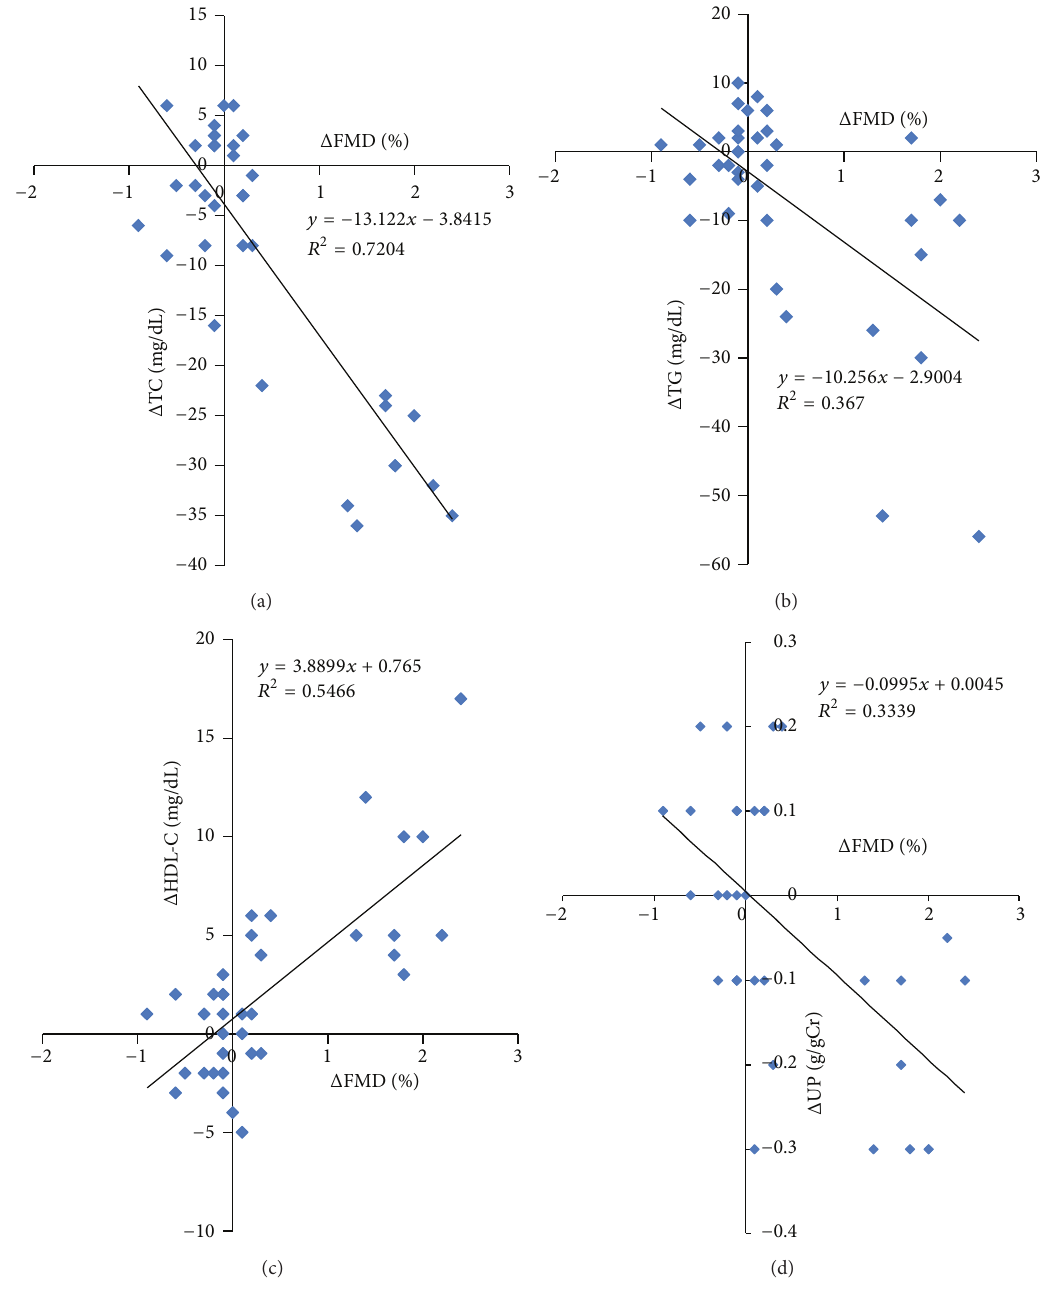
Figure 2: Relationship between changes in flow-mediated vasodilation (FMD) and that of TC ( 𝑃 < 0.0001 ), TG ( 𝑃 < 0.0001 ), HDL-C ( 𝑃 < 0.0001 ), and UP ( 𝑃 < 0.05 ). TC: total cholesterol; TG: triglycerides; HDL-C: high density lipoprotein cholesterol; and UP: urinary